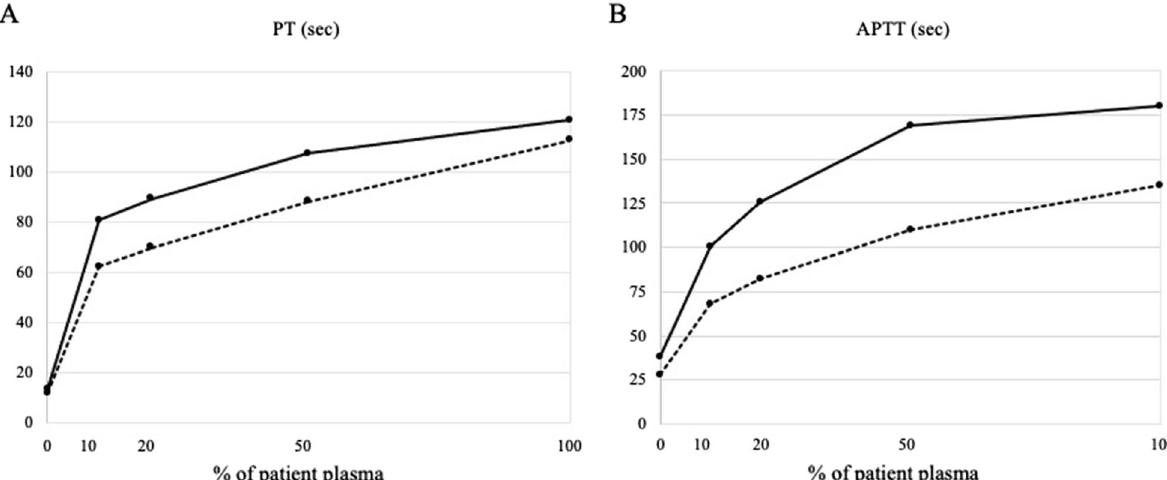
Fig. 2 Results of a cross-mixing test using normal stocked plasma. The immediate reaction and that after 2 h show a convex graph as the inhibitor pattern both in prothrombin time ( A ) and in activated partial thromboplastin time ( B